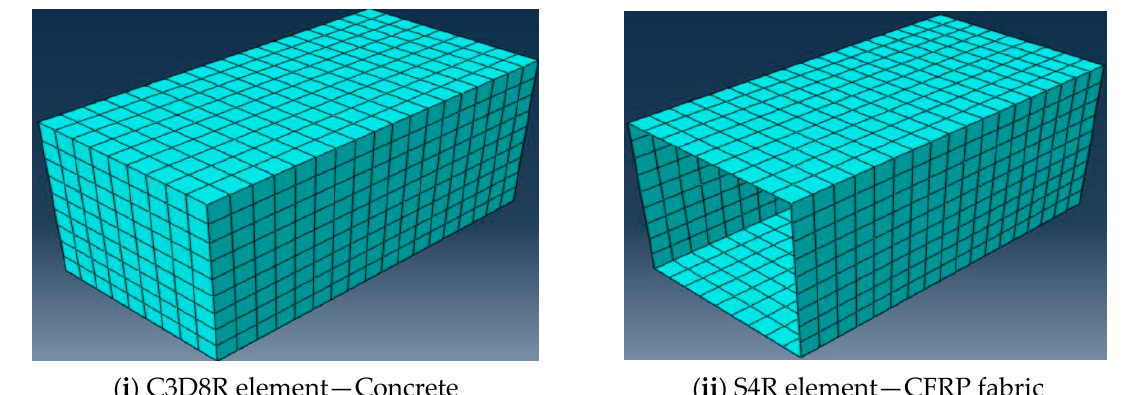
Figure 11. Meshing of concrete and CFRP fabric using ABAQUS.